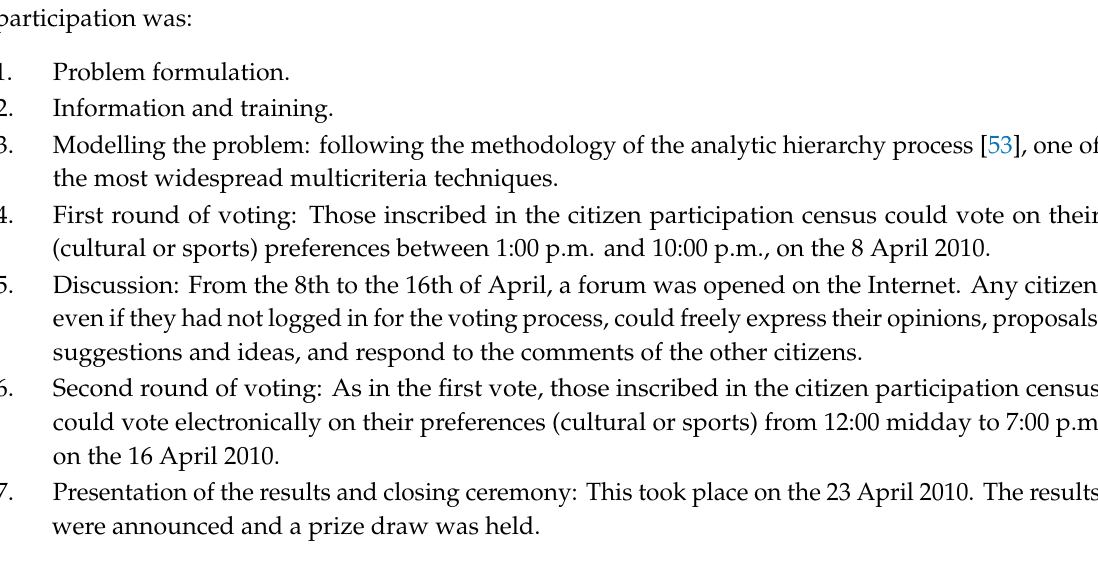
Table 2. Fundamental scale [53].